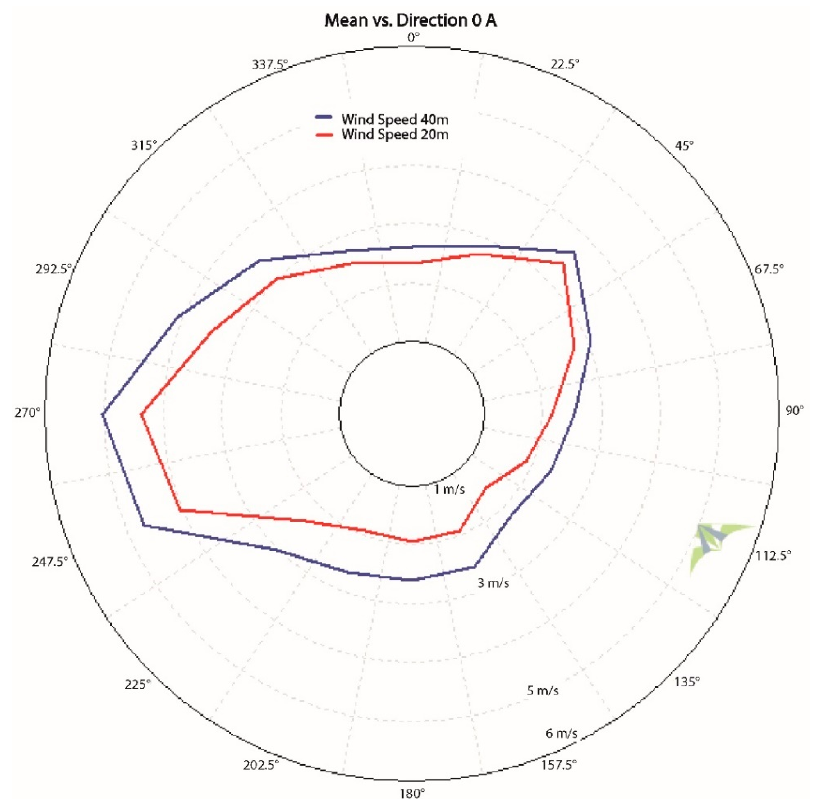
Figure 8. Wind direction frequency. Source: generated by the software.